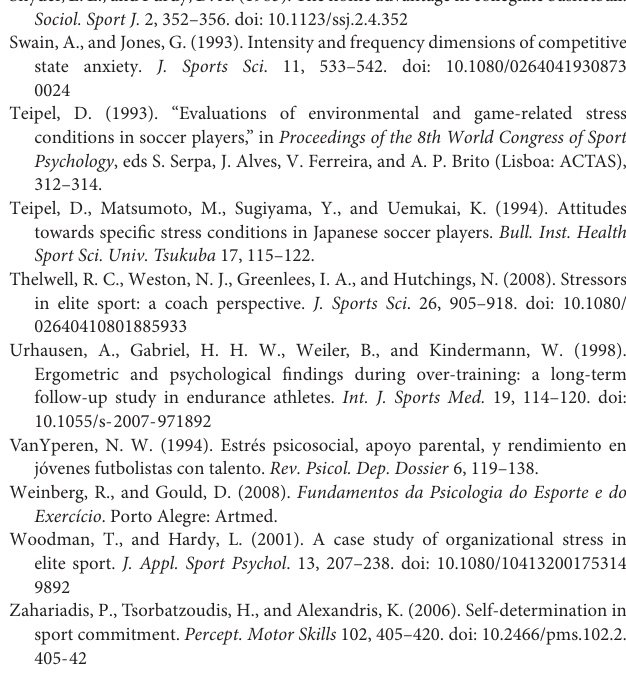
elite figure skaters: I. Introduction to the project. J. Sports Exerc. Psychol. 11, 54–64. doi: